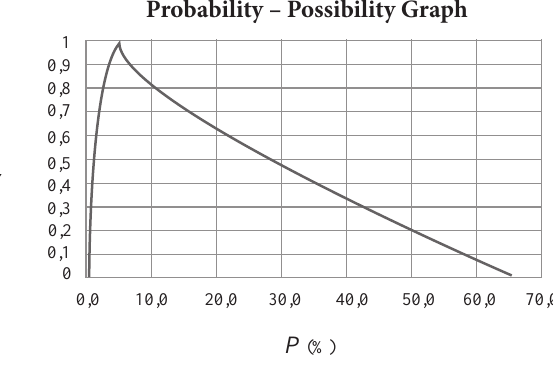
Fig. 3. The possibilities of probabilities P (Loss)